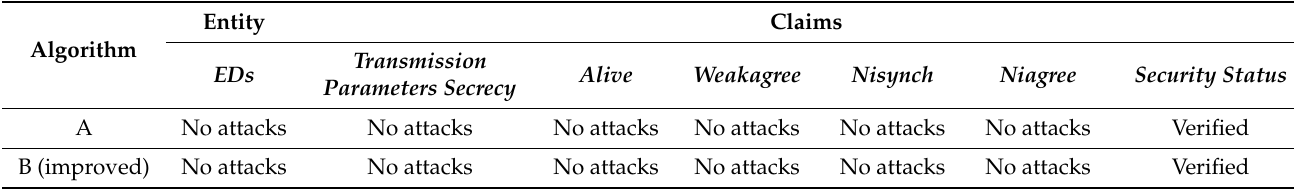
Table 2. EDs security claims.